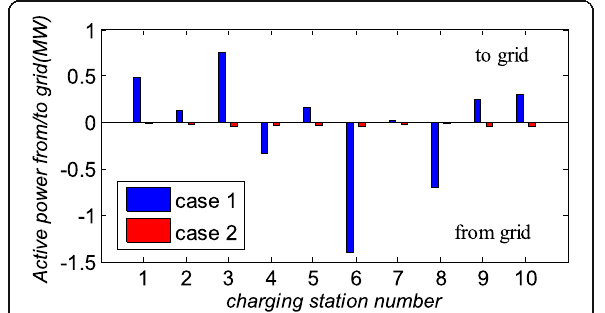
Fig. 9 DG utilization efficiency (normal